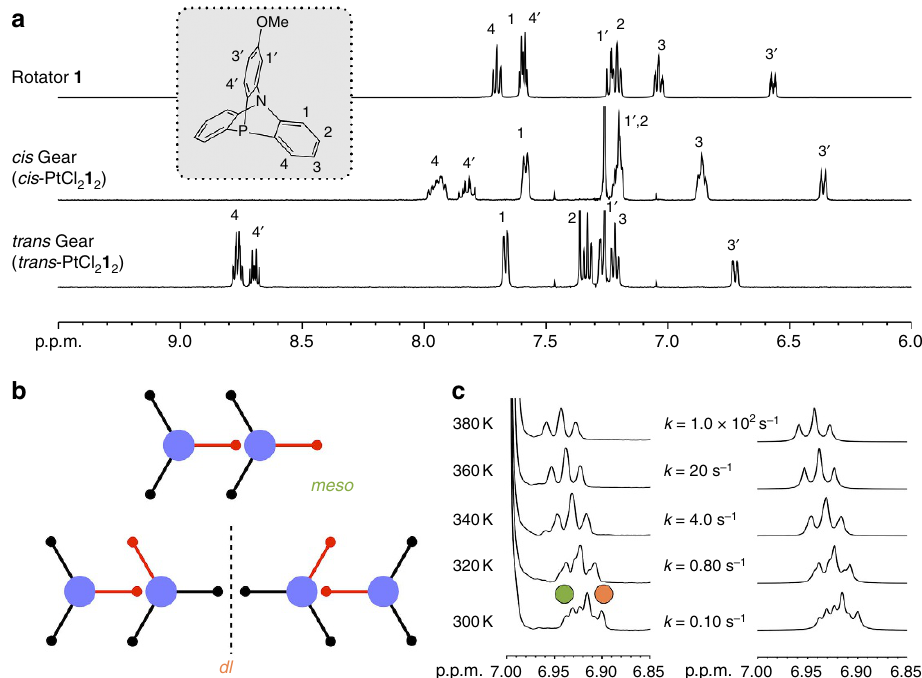
Figure 2 | 1 H NMR spectra of rotator 1 and cis - and trans -PtCl 2 1 2 . The signals of a methoxy group of rotator 1 ( B 3.8p.p.m.) are omitted for clarity. For the whole NMR spectra, see the Supplementary Figures 7, 11 and 16. ( a ) 1 H NMR spectrum of (i) 1 , (ii) cis -PtCl 2 1 2 and (iii) trans -PtCl 2 1 2 (500MHz, CDCl 3 , 300K). The 1 H NMR spectra of cis -PtCl 2 1 2 include meso and dl isomers in a B 1:2 ratio. ( b ) Isomerism based on rotational conformation. ( c ) Observed and simulated spectra of 3-positions’ proton at varied temperatures (500MHz, TCE- d 2 /toluene- d 8 ¼ 1:1). Left: observed spectra in the range from 380 to 300K. Right: simulated spectra based on the two-state exchange model. Green and orange circles denote meso and dl isomers, respectively.